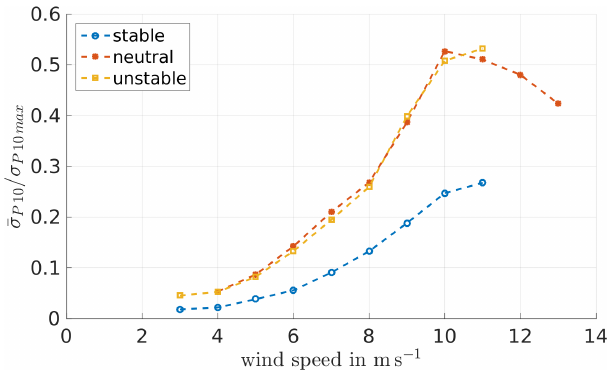
Figure 8. Standard deviation for 10min intervals of the mea- sured turbine power output, calculated according to σ P (cid:115) N meas (cid:80) 1 | P ( t k ) − P | 2 , where P ( t k ) denotes the power 10 N meas − 1 k = 1 data measured in 50Hz, P 10 the 10min average and N meas the number of measurements within the 10min interval, normalised by the maximum 10min standard deviation of the power, for May/June 2017, and sorted and averaged according to stability (de- termined from eddy-covariance data) and wind